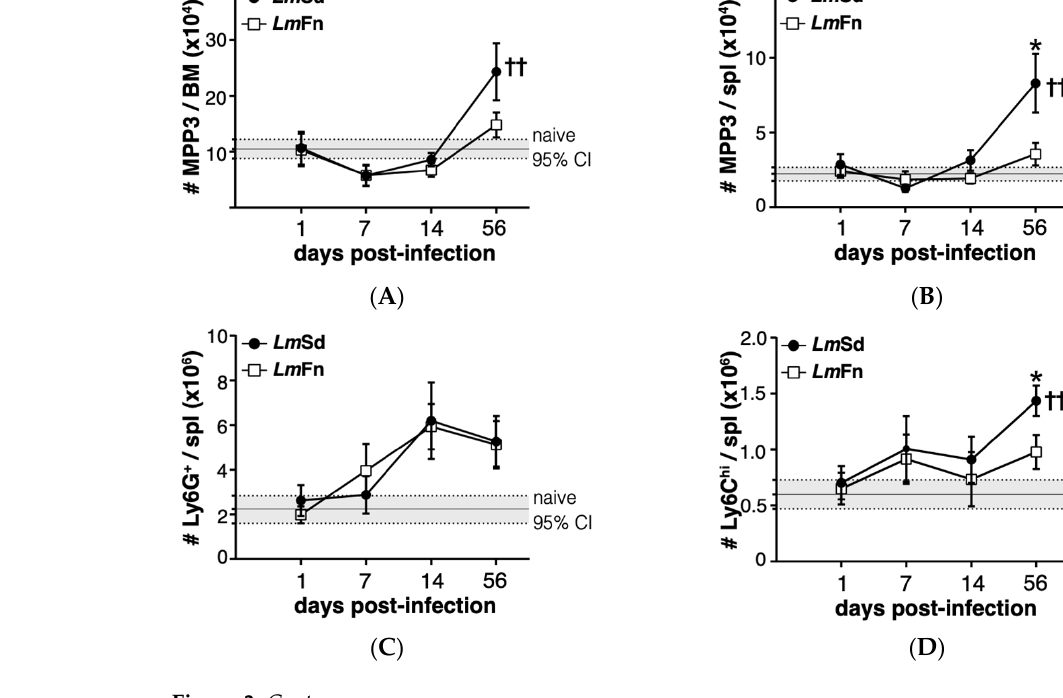
Figure 3. Induction of myeloid-biased multipotent progenitors is associated with an accumulation of myeloid cells during persistent infection with L. major . The number of cells within the CD48 + CD150 − CD135 − MPP3 subset of hematopoietic progenitor cells in ( A ) bone marrow and ( B ) spleen at different times post-infection. The number of ( C ) Ly6G + granulocytes; ( D ) Ly6C hi Ly6G −